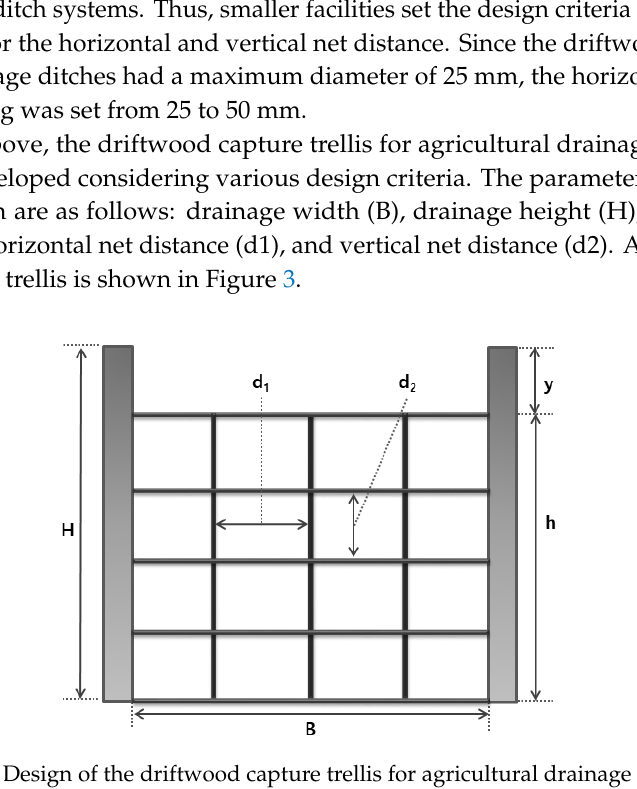
Figure 3. Design of the driftwood capture trellis for agricultural drainage ditches.